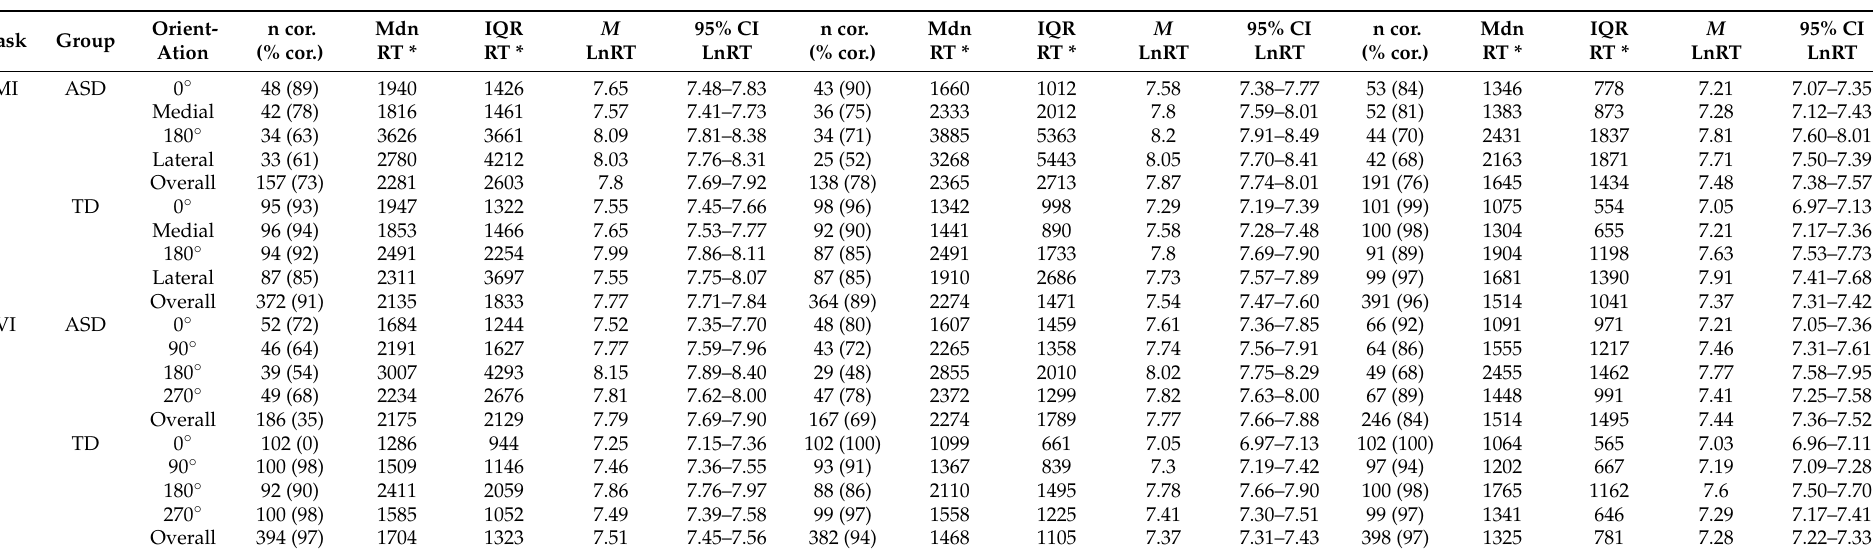
Table 3. Descriptive statistics of the percentage and number of correct responses, RTs and LnRTs and associated data presented by group, orientation, overall orientations, and age level for the MI and VI